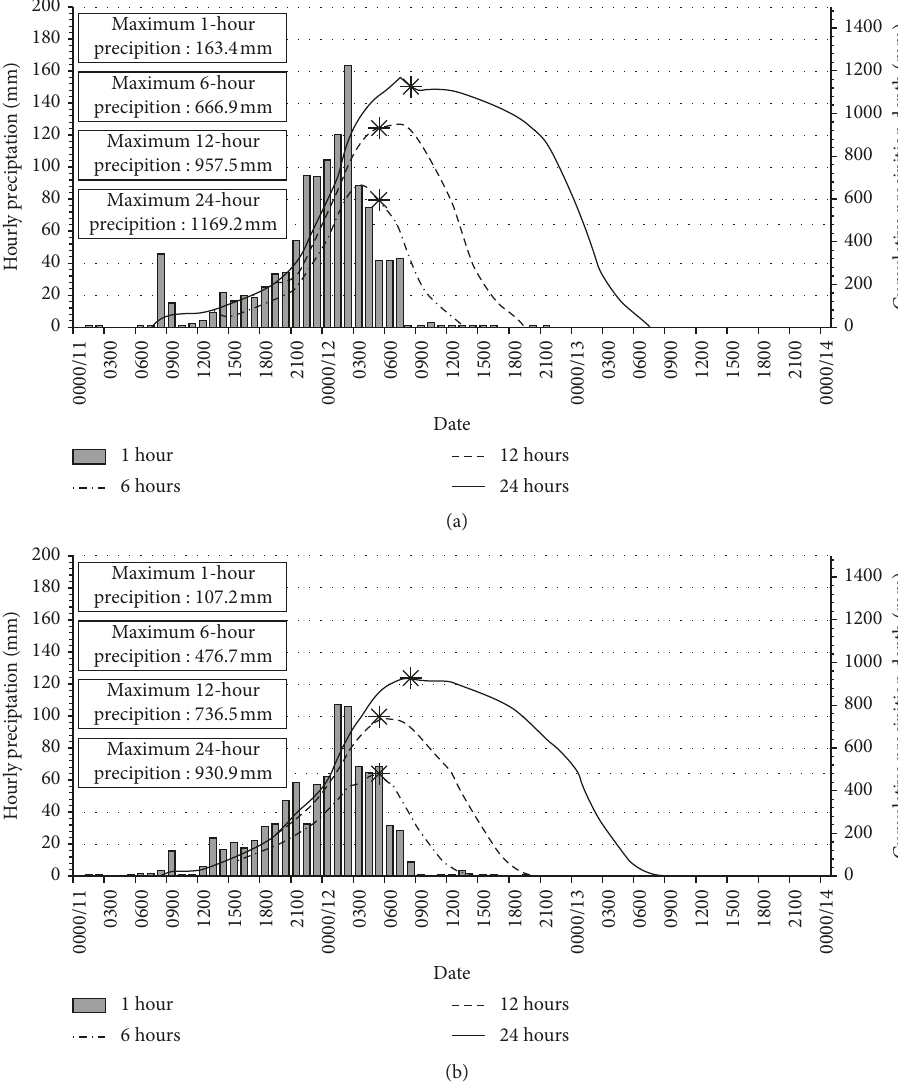
Figure 10: Rainfall hyetograph and rainfall depth for several durations produced at Busan using (a) MP 3.0–3.5 combination and (b) MP 2.5–3.0